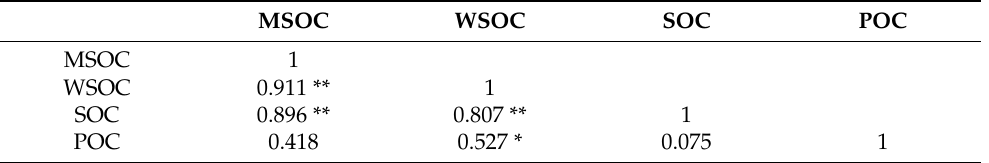
Table 1. Correlation between MSOC, WSOC, SOC, and POC. MSOC WSOC SOC POC MSOC 1